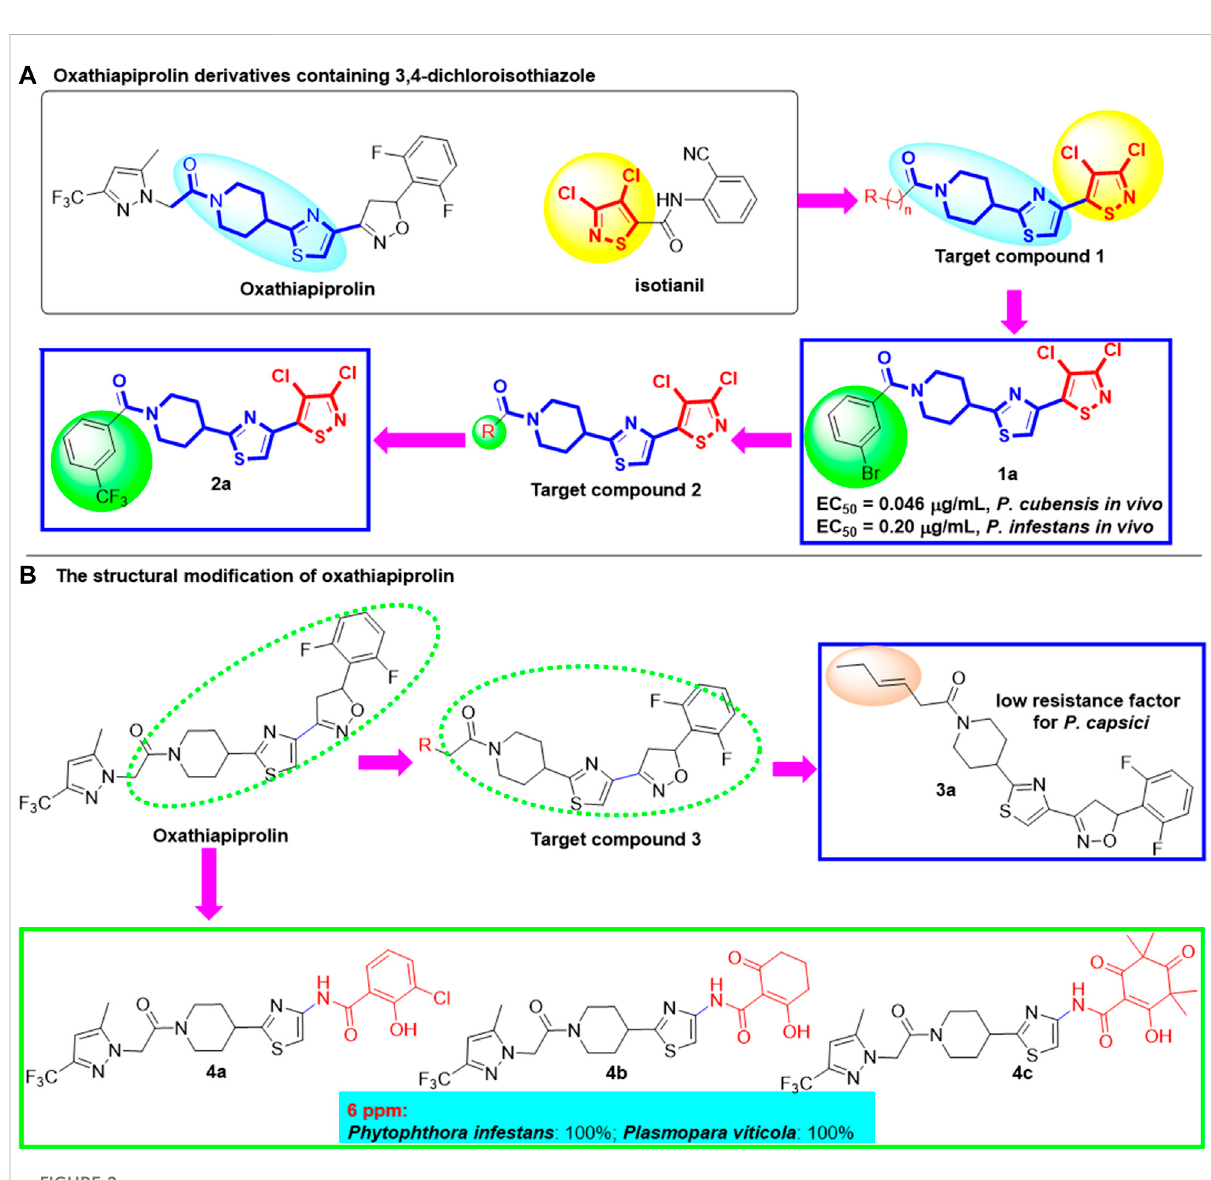
FIGURE 2 Terminal group replacement of